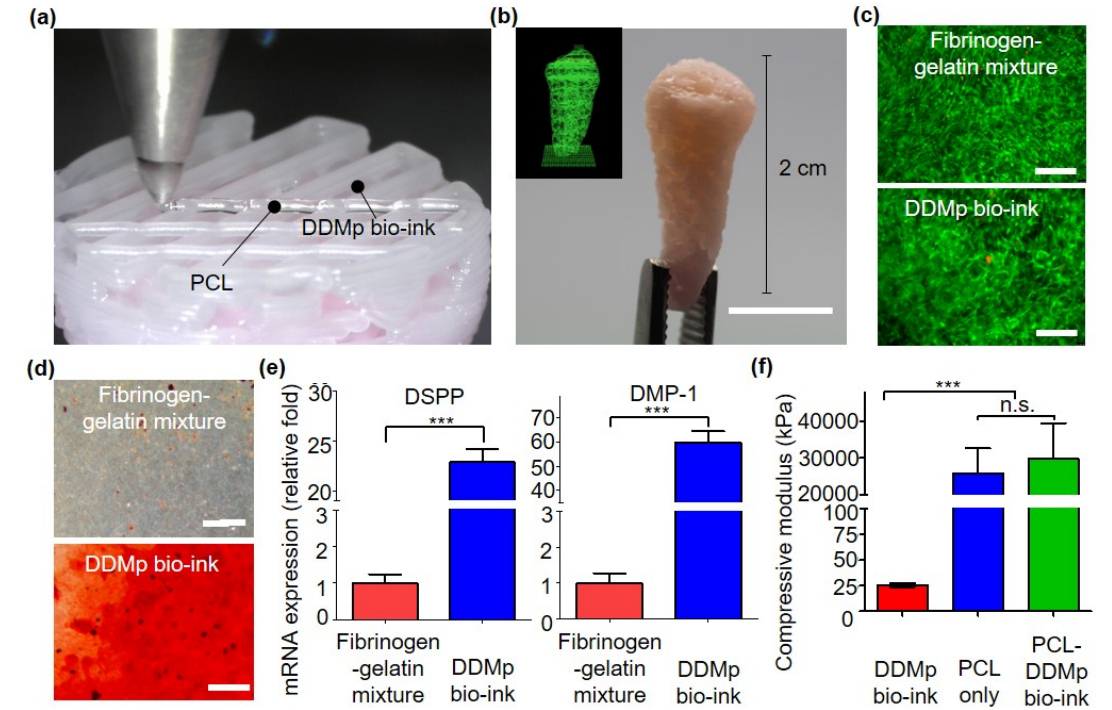
Figure 7. The 3D hybrid bioprinting of human tooth-shaped construct with DPSC-laden DDMp bio-ink and polycaprolactone (PCL) ( a ) 3D hybrid bioprinting procedure ( b ) visualized printing code (inset) and its fabrication result of 3D human tooth-shaped construct with the DPSC-laden bio-ink and PCL (scale bar: 10 mm). ( c ) Live/dead staining results of bioprinted DPSC-laden fibrinogen–gelatin mixture and 10% w / v DDMp bio-ink at day 7 (Scale bar: 500 µ m). Alizarin red staining results ( d ) and relative mRNA expression levels (Dentin Sialo-phosphoprotein (DSPP) and Dentin matrix protein-1 (DMP1) (scale bar: 200 µ m)) ( e ) of the constructs printed with DPSCs-laden DDMp bio-ink (10% w / v ) after culturing with odontogenic differentiation medium for 15 days (*** p < 0.001, n = 3, all the experiments were performed in triplicate). ( f ) Compressive modulus of 3D-printed DDMp bio-ink only, PCL only and PCL/DDMp bio-ink constructs.